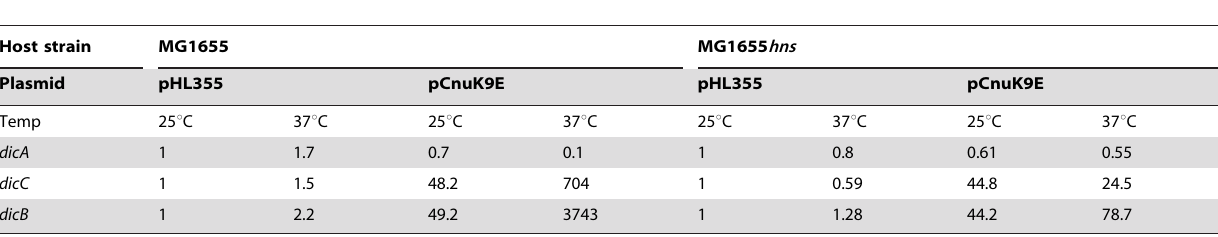
Table 1. Relative concentration of dic